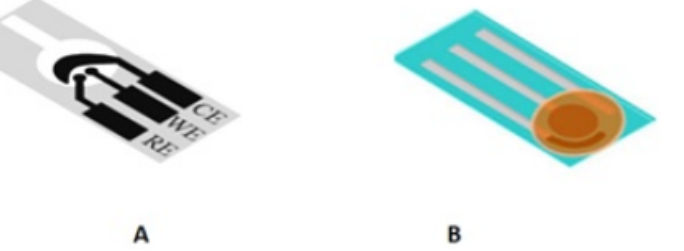
Figure 1. Design of 2D e-PAD biosensor. The 2D designs were adapted from the references: ( A ) strip [19], and ( B ) paper disk [47]. Counter electrode (CE), working electrode (WE), and reference electrode (RE).